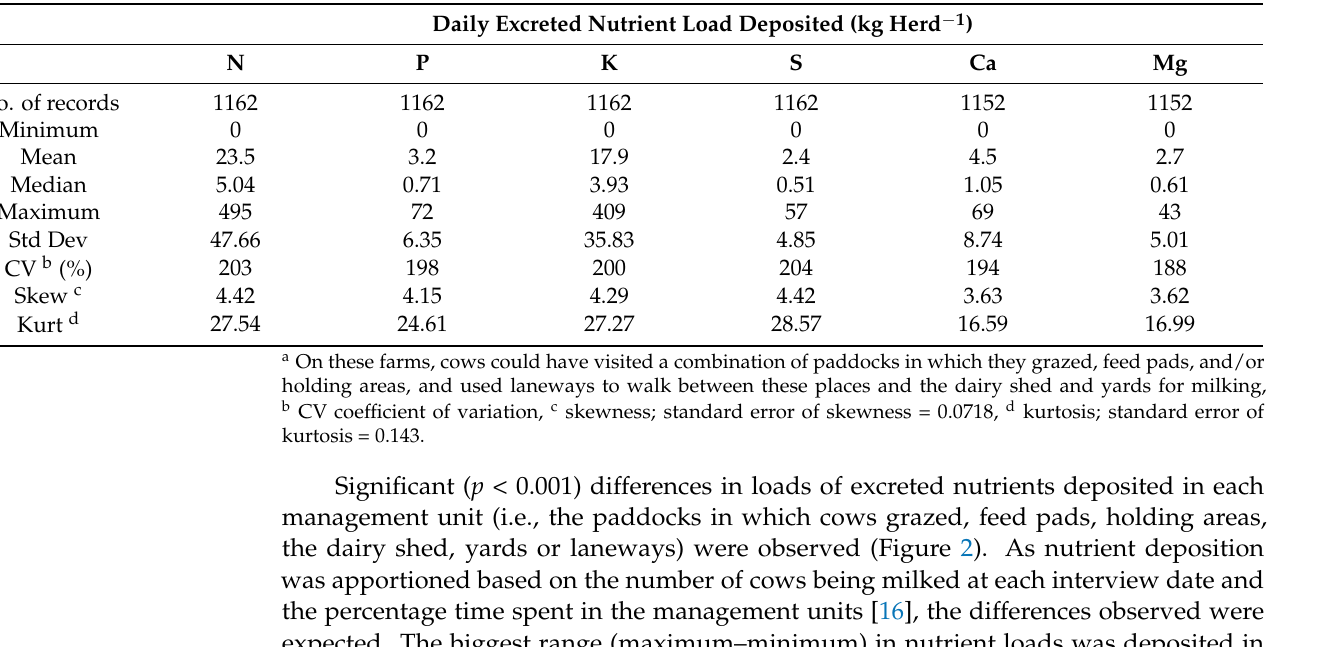
Table 2. Summary statistics for the estimated daily load (kg herd − 1 ) of excreted nutrients (N, P, K, S, Ca, Mg) deposited by lactating herds on 43 grazing system dairy farms, based on the time the cows spent in all places a visited over the 24 h preceding each of the five interview